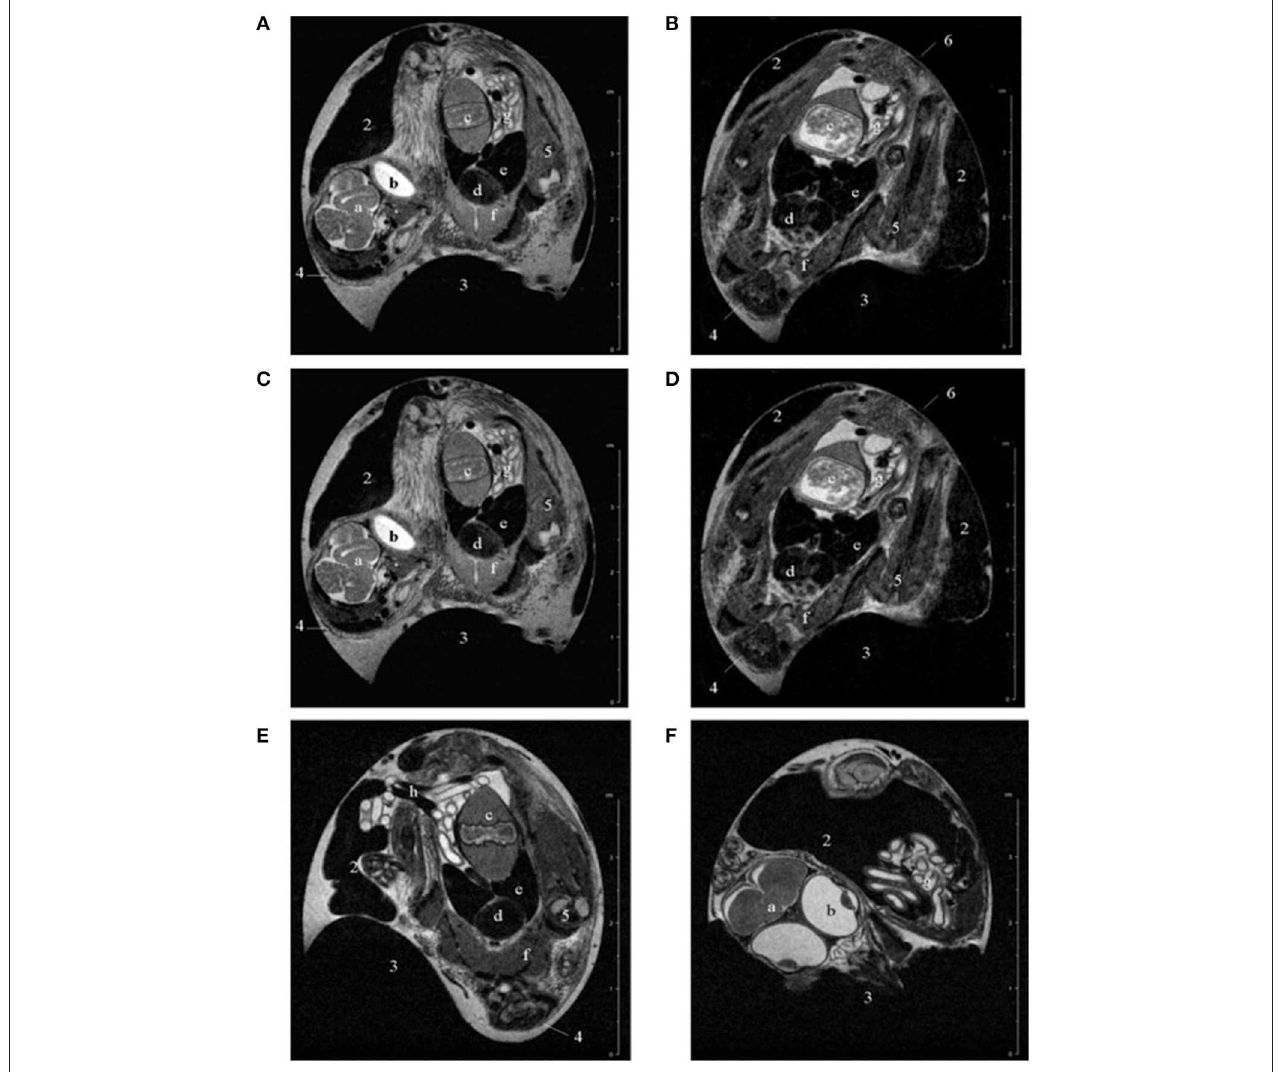
FIGURE 2 | Representative examples of T2-weighted multislice scans of chick embryos in ovo at (A) 12, (B) 15, (C) 17, (D) 18, (E) 19, and (F) 20 days of incubation. 1, albumen; 2, yolk; 3, air sac; 4, head; 5, limb; 6, rump; a, brain; b, eye; c, gizzard; d, heart; e, liver; f, pectoral muscles; g, intestine; h, umbilical vessels. The complete scans can be viewed at www.gla.ac.uk/7tmr/chickegg.htm. This research was originally published in JMRI: Noninvasive Monitoring of Chick Development In Ovo Using a 7T MRI System From Day 12 of Incubation Through to Hatching. Bain et al.